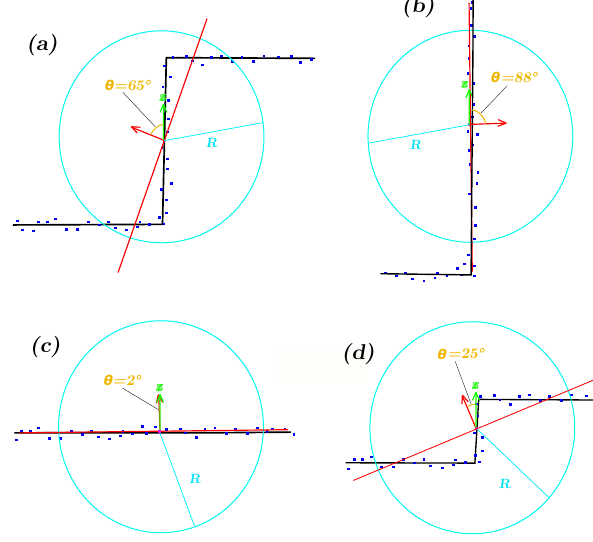
Figure 1: Four different profile patterns depicted here in 2D for better understanding. (a), (b), (c) and (d) schemes respectively represent a stair, a facade, the ground and a road side (usually lower than a stair). The red arrows correspond to computed nor- mals whereas the green one is the z vector. Blue points are LIDAR points, the red line denotes the estimated plane (using RANSAC) based on the LIDAR points within the blue circle. The yellow arrow is the θ feature, i.e., the angle deviation with the z vector.